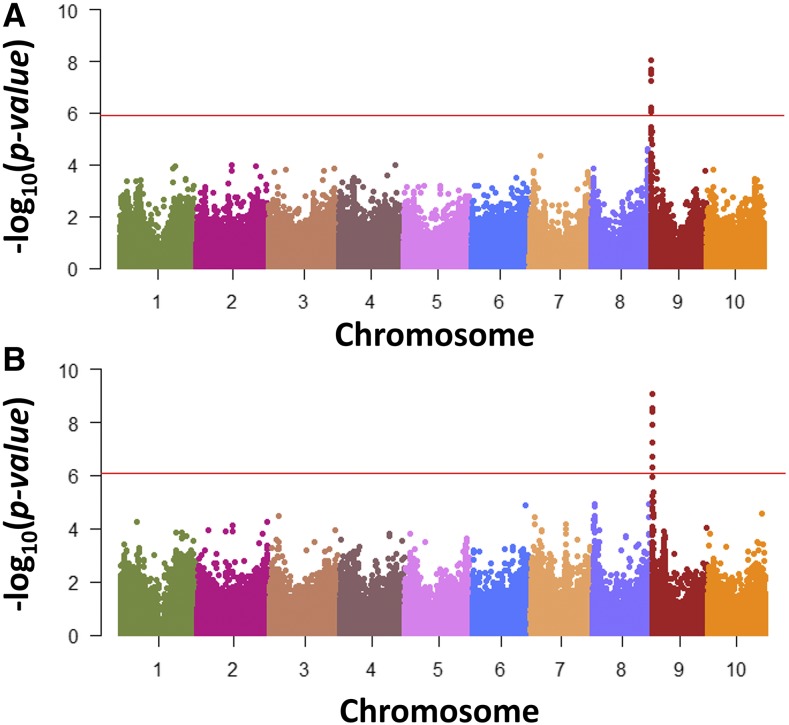
Genome-wide association analysis of anthracnose resistance using quantitative data. (a) Manhattan plots for ECMLM using Ethiopian sorghum germplasm and red horizontal line referring to an experiment-wise significance threshold of P < 0.05 based on 1000 permutations. (b) Manhattan plots for ECMLM using both Ethiopian sorghum germplasm and the U.S. Sorghum Association Panel and red horizontal line referring to an experiment-wise significance threshold of P < 0.05 based on 1000 permutations.